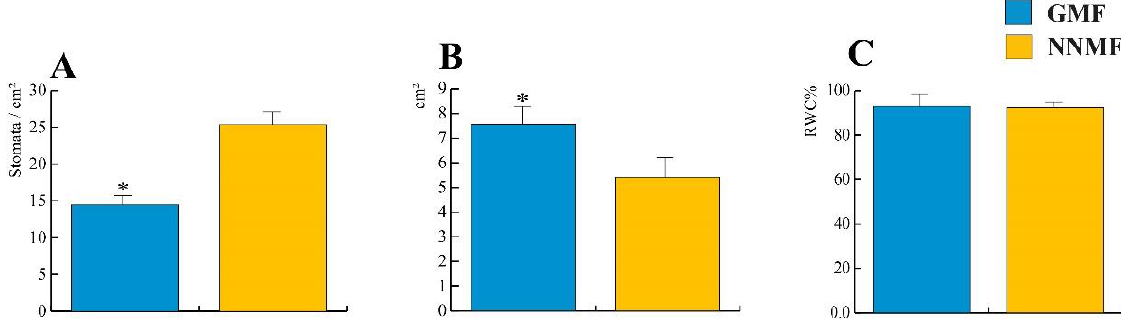
Figure 1. Effect of reducing the GMF on Lima bean leaves. ( A ) Stomatal density; ( B ) leaf area; and ( C ) relative water content (RWC) %. Bars represent standard deviation, asterisk indicates significant ( p < 0.05) differences between GMF and NNMF.